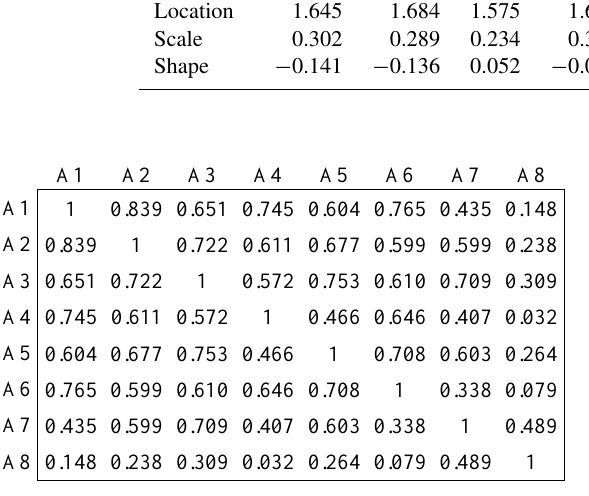
Figure 7. Comparison of conventional joint CDF and Kendall CDF in subfigures (a) with the general axes and (b) with the Hessian